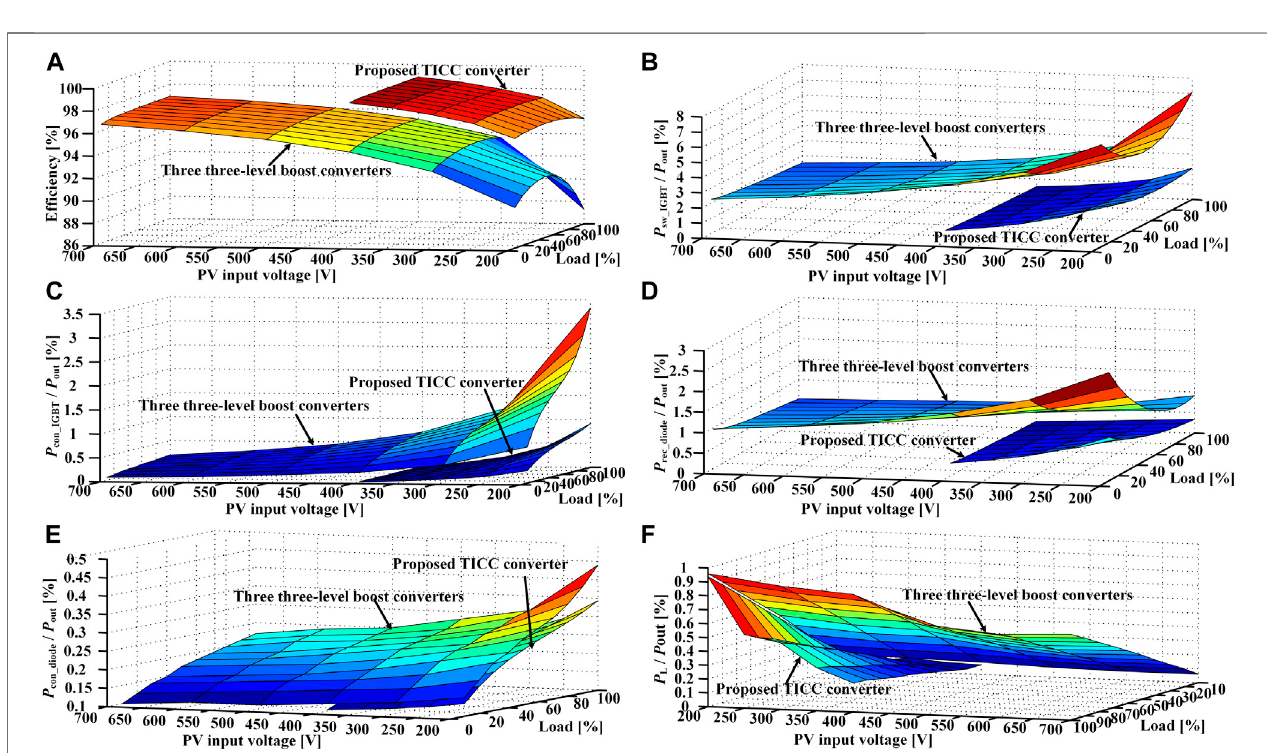
FIGURE14|(A) Ef fi ciencyoftheproposedTICCconverterandthreethree-levelboostconverters, (B) fractionofpowerdissipatedbyIGBT ’ sswitchingamongtwo converters, (C) fraction of power dissipated by IGBT ’ s conduction among two converters, (D) fraction of power dissipated by the diode ’ s reverse recovery among two converters, (E) fraction of power dissipated by the diode ’ s conducting among two converters, and (F) fraction of power dissipated on the inductor among two converters.